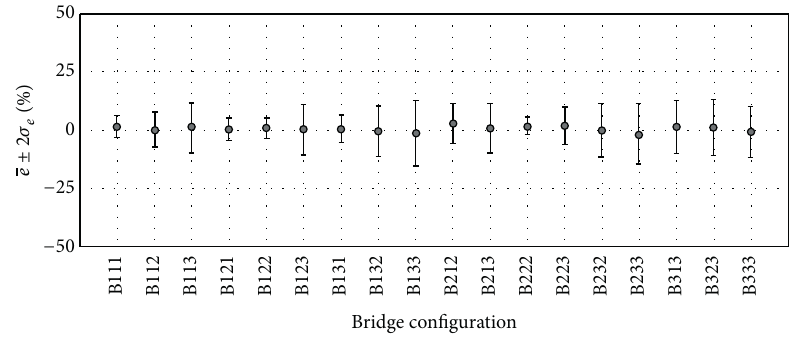
Figure 7: Mean and 95% confidence range for column base moments.